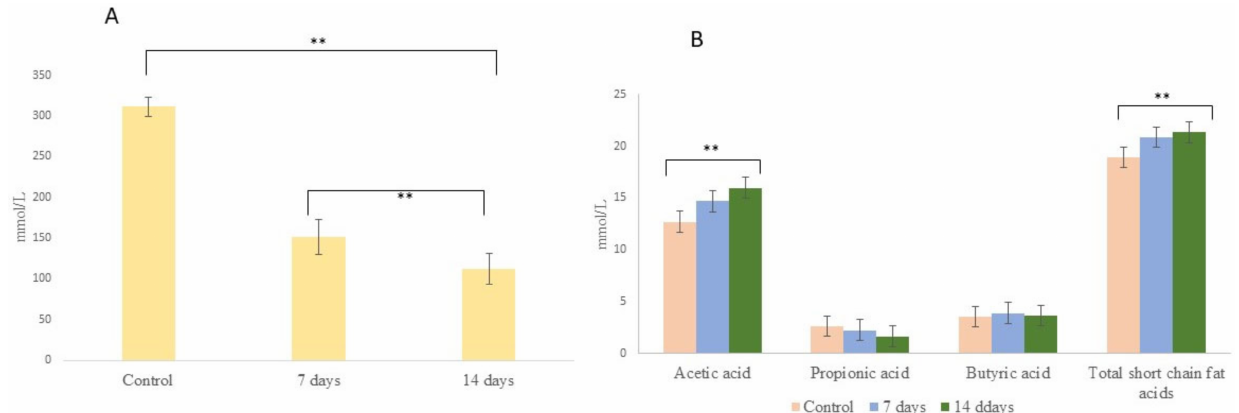
Figure 6. Ammonium ( A ) and short-chain fatty acid ( B ) concentrations in the ascending colon in microbiota of individuals with mild anxiety using the SHIME ® model over the course of the 7 or 14 days of treatment with L. helveticus R0052 and B. longum R0175. Asterisks (**) represent significant differences relative to control according to the paired t -test (** p < 0.01).